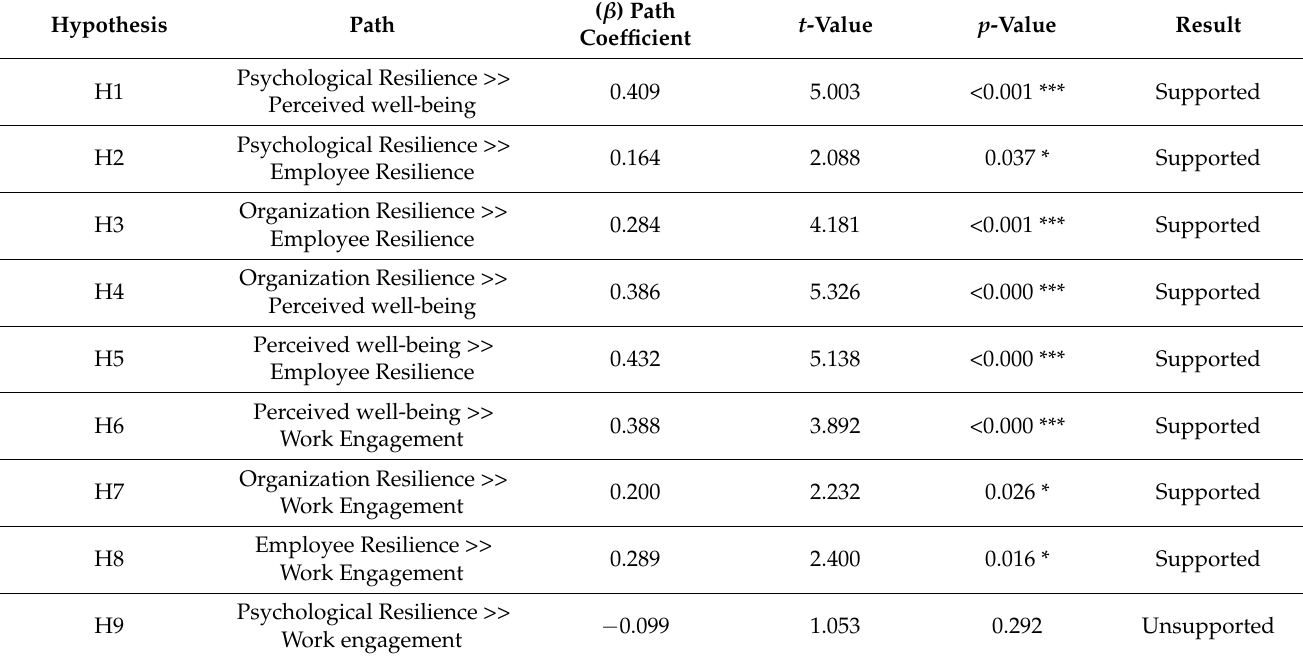
Table 4. Results of hypotheses